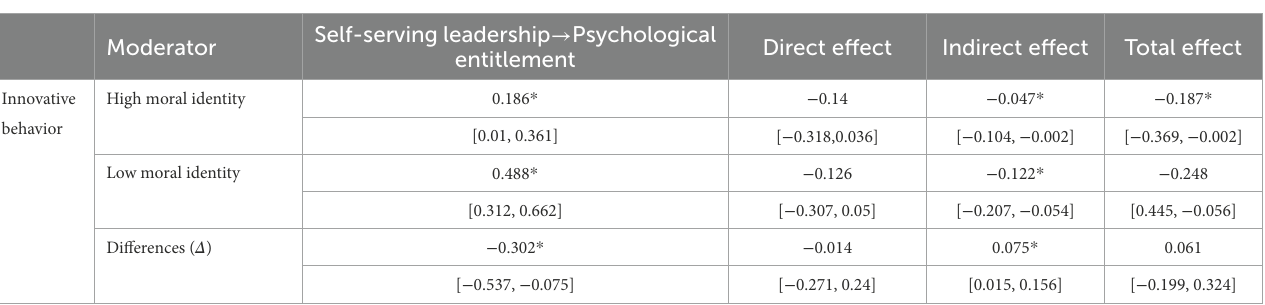
TABLE 5 Results of moderated mediation